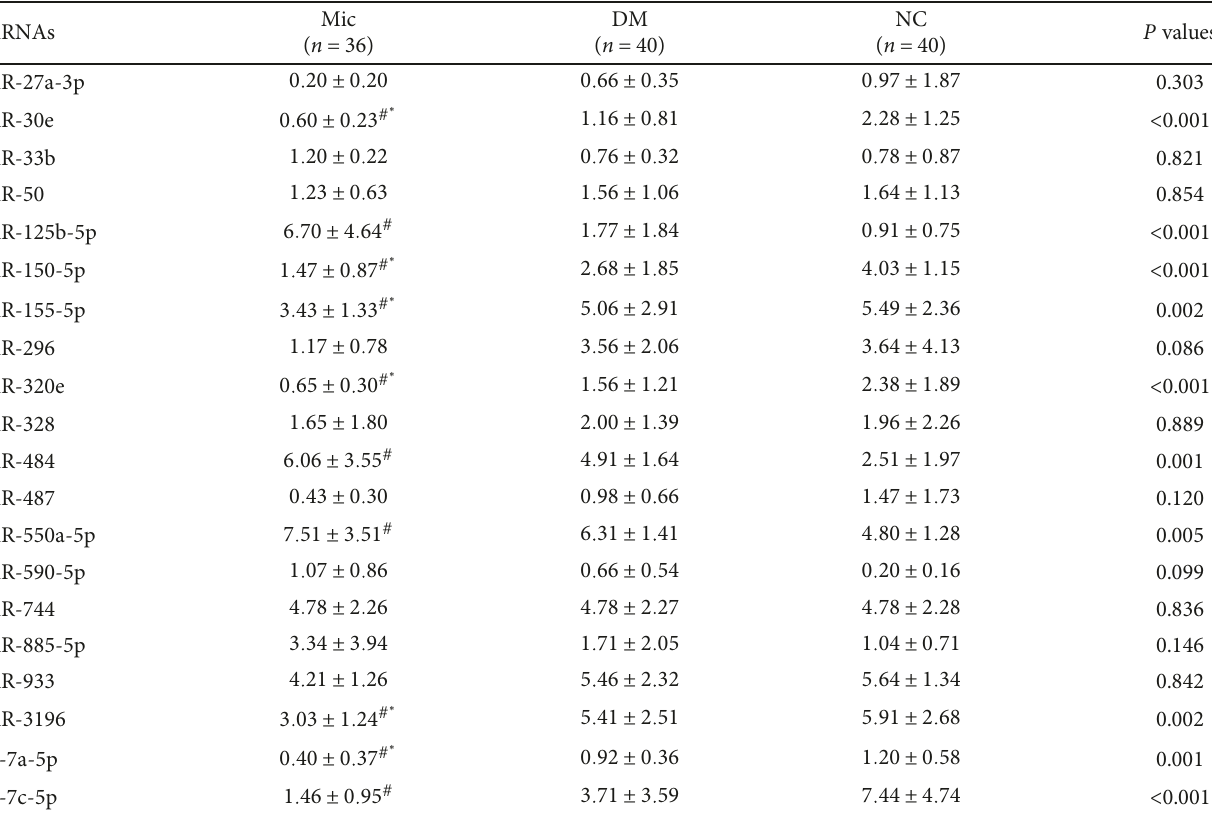
Table 2: Expression of plasma miRNAs in the three